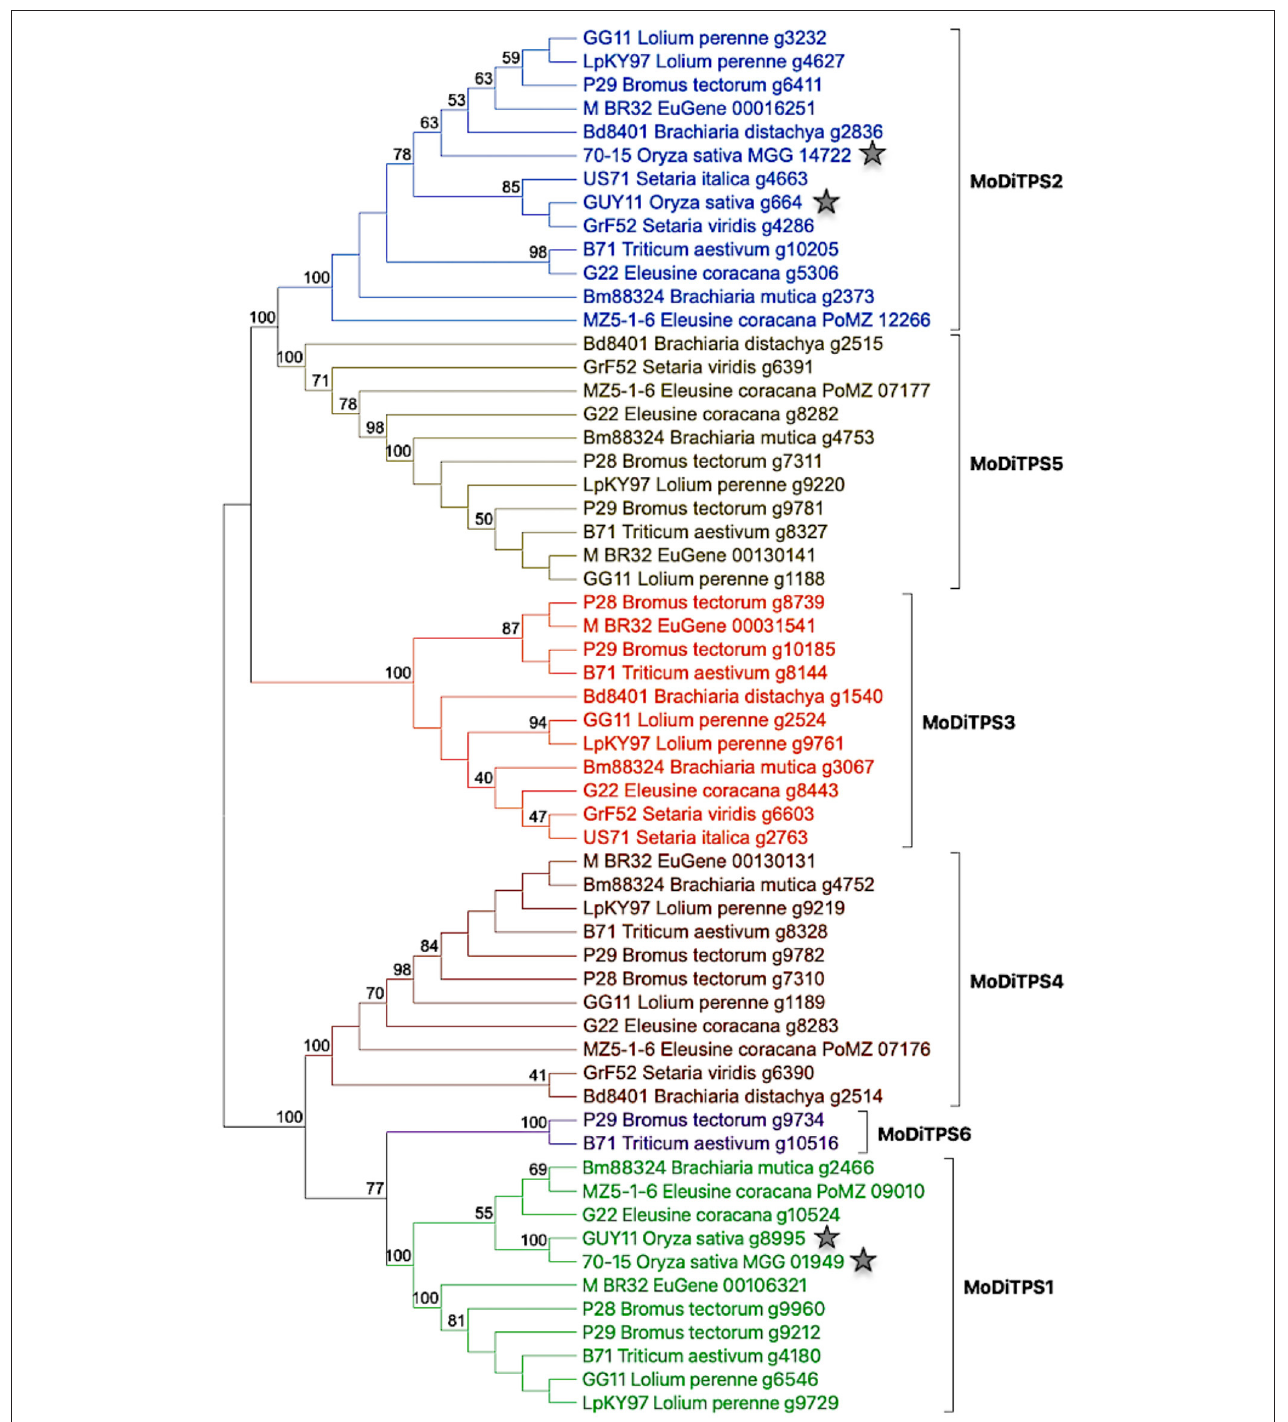
FIGURE 1 | phylogeny based expansion of diterpene synthases in Magnaporthe oryzae pathotypes. Phylogenetic tree showing relationship among 59 DiTPS enzymes belonging to 14 M. oryzae pathotypes. The DiTPS are named by their genome name followed by their host plant and annotation number. The diterpene synthases of rice pathotypes are indicated with a star to illustrate relative expansion of DiTPSs in other grass pathotypes. The details of genomes and DiTPSs present in them are illustrated in Supplementary Table 1 . The sequences were aligned using Muscle alignment tool and maximum likelihood tree was constructed using MEGAX software with default parameters and 100 bootstrap